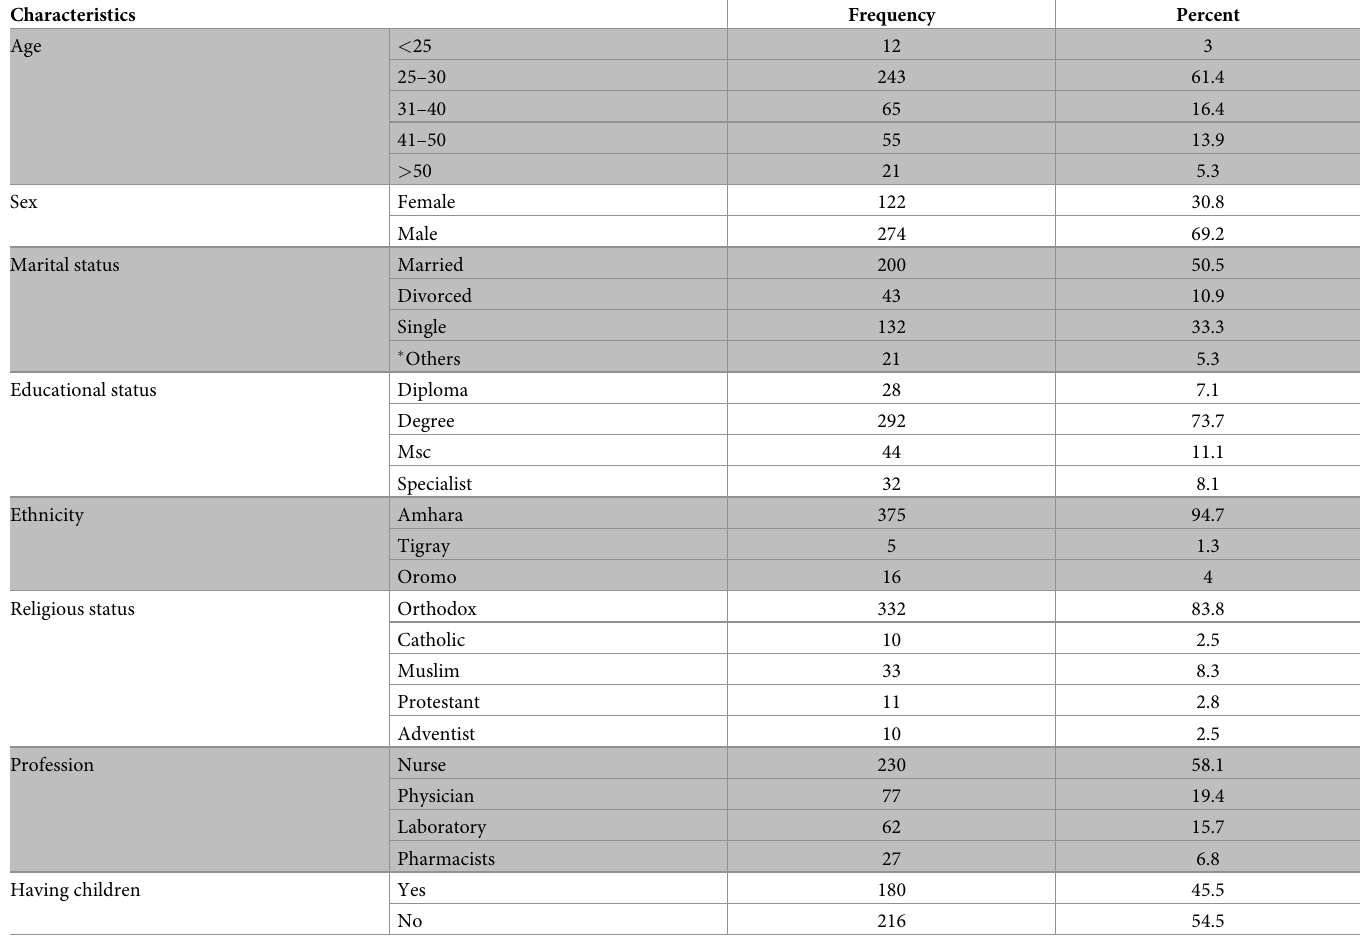
Note that: � other–separated and widowed.